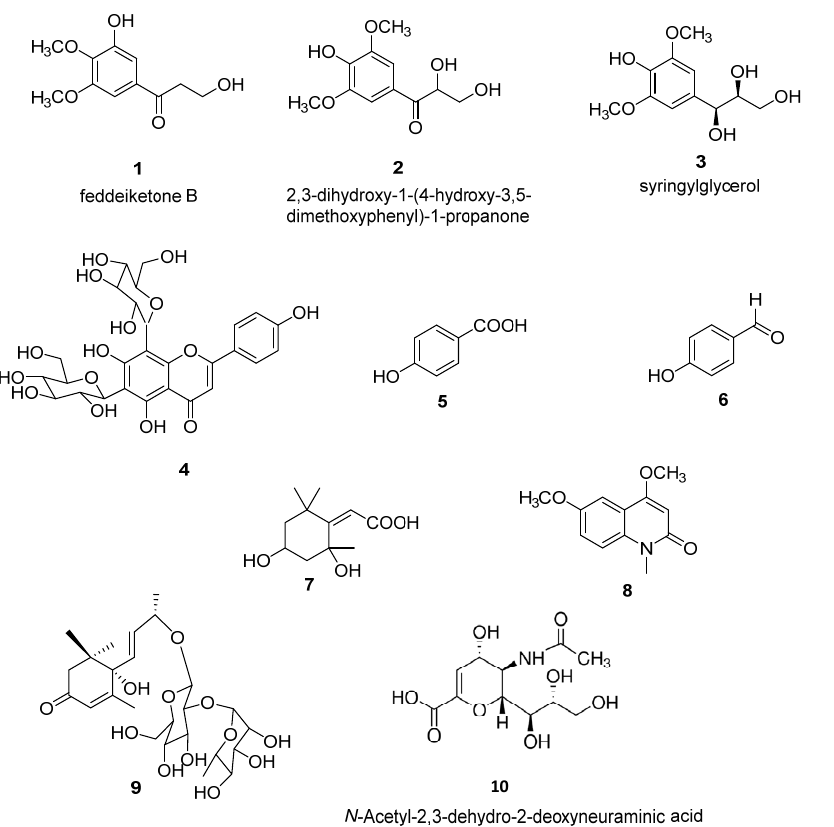
Figure 1. Chemical structures of compounds ( 1 – 9 ) isolated from Olyra latifolia and of N -Acetyl-2,3- dehydro-2-deoxyneuraminic acid (DANA) ( 10 ).